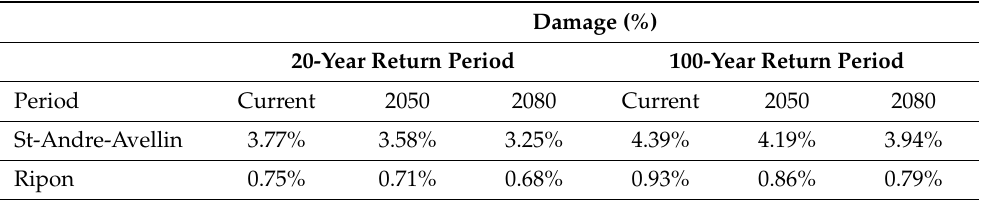
Table 3. Projected damage changes expressed in percentage for the 20- and 100-year return periods for Ripon and St-Andre-Avellin (current (baseline), 2050, and 2080). Damage ( % ) 20-Year Return Period 100-Year Return Period Period Current 2050 2080 Current 2050 2080 St-Andre-Avellin